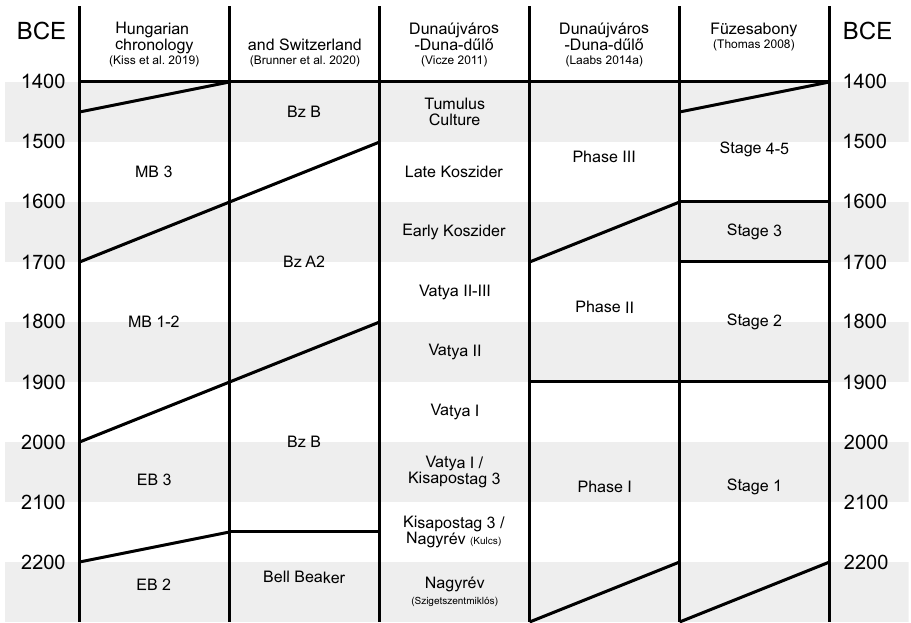
Figure 2: Synchronization of relative chronologies of the Early and Middle Bronze Age in parts of the Carpathian Basin ( Kiss et al., 2019; Thomas, 2008 ) , Southern Germany/Switzerland ( Brunner et al., 2020 ) and the cemetery of Dunaújváros ( Laabs, 2014a; Vicze, 2011 )